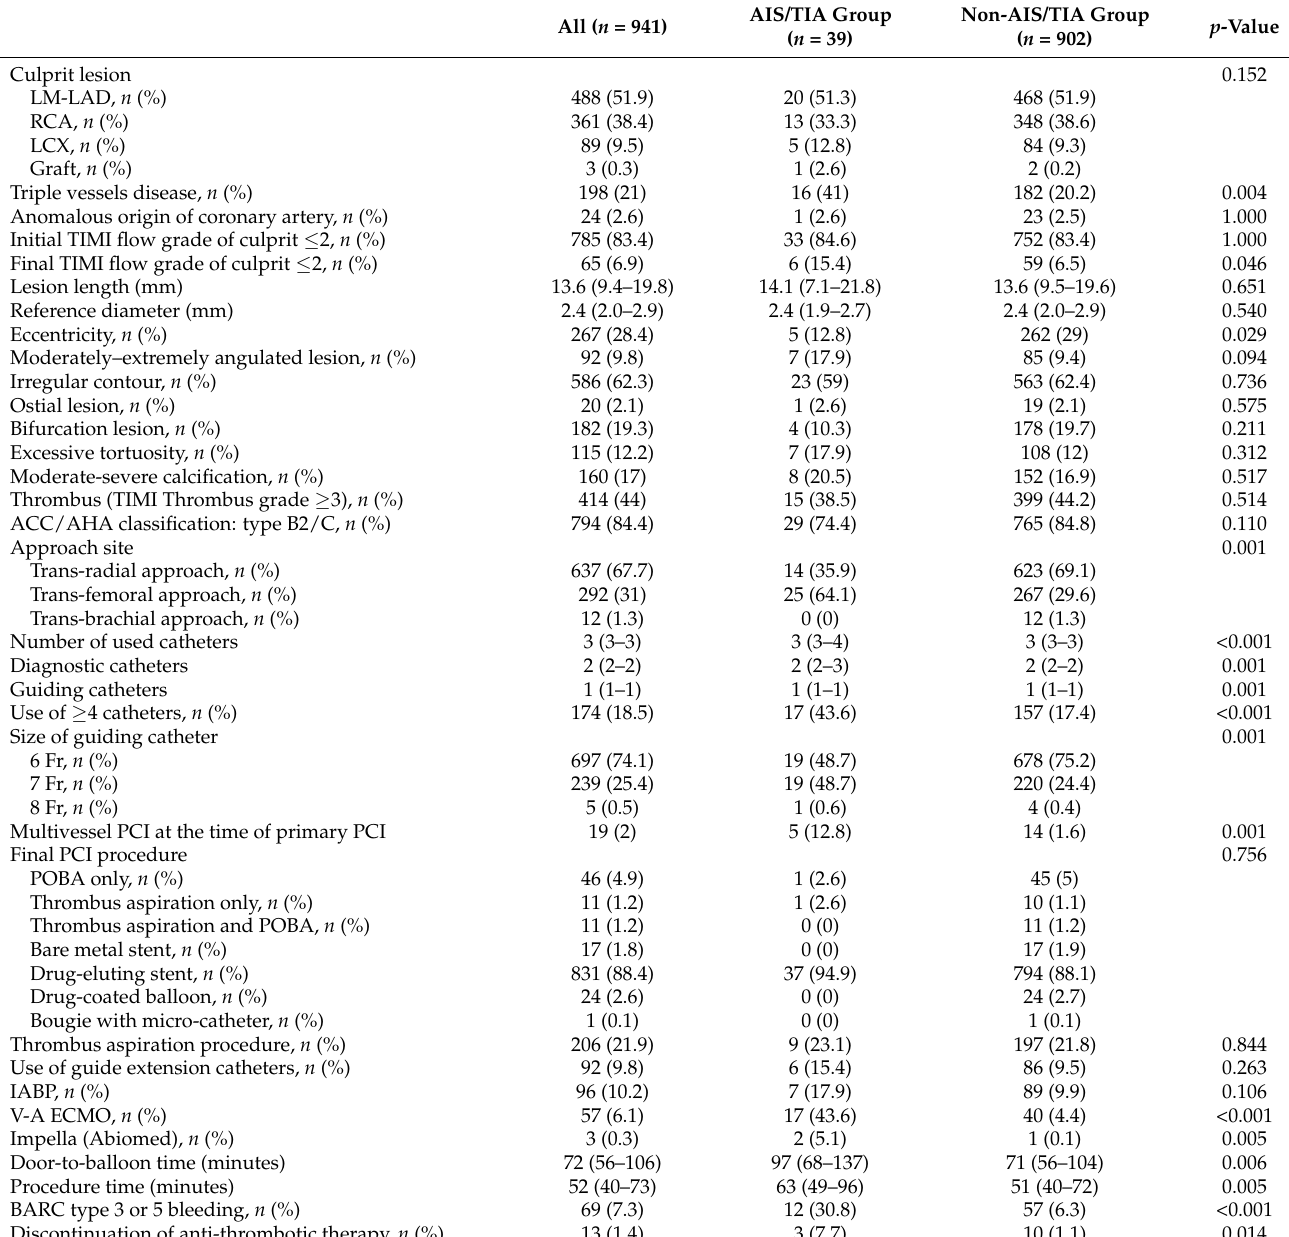
Table 2. Comparison of lesion and procedural characteristics of primary PCI between the AIS/TIA group and the non-AIS/TIA